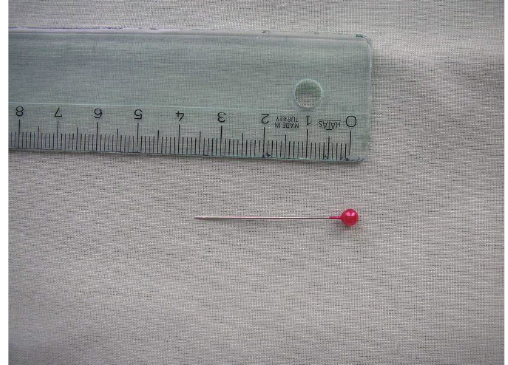
Figure 2: The pin which was removed from bladder has one sharp end and one plastic bead.